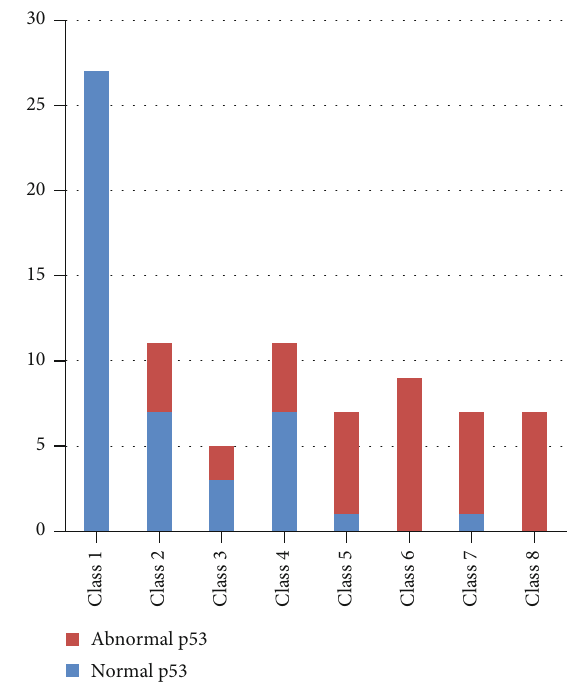
Figure 4: Distributions of patients according to cytometry classes vs. p53